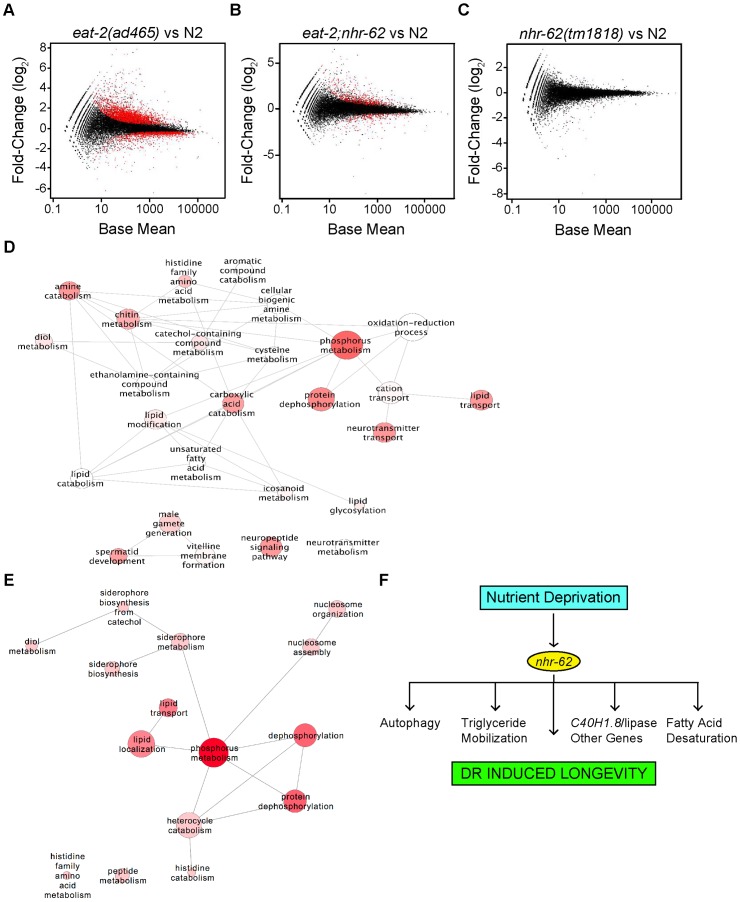
Expression profile analysis of eat-2 and nhr-62 regulated genes.Scatter plots of log2 fold-changes versus mean expression level. Red dots highlight differentially expressed genes at FDR<0.05 for (A) eat-2(ad465) versus wild-type (N2) (B) eat-2;nhr-62 versus wild-type (N2) and (C) nhr-62(tm1818) versus wild-type (N2). (D) ReviGO analysis to summarize all GO-BP terms returned by DAVID with p value <0.1 when analyzing Gene-list “eat-2-vs-N2” and (E) list of DR regulated genes rescued by nhr-62(tm1818). Bubble size indicates the frequency of the GO term from the GOA database, bubble color is dictated by the p value with a darker color being a lower p value, and similar GO terms are linked by lines where the line thickness indicates degree of similarity. (F) Model for DR. See Figure S8 for Euclidean distances between samples, Venn diagram, and qPCR validation of RNA-seq data.